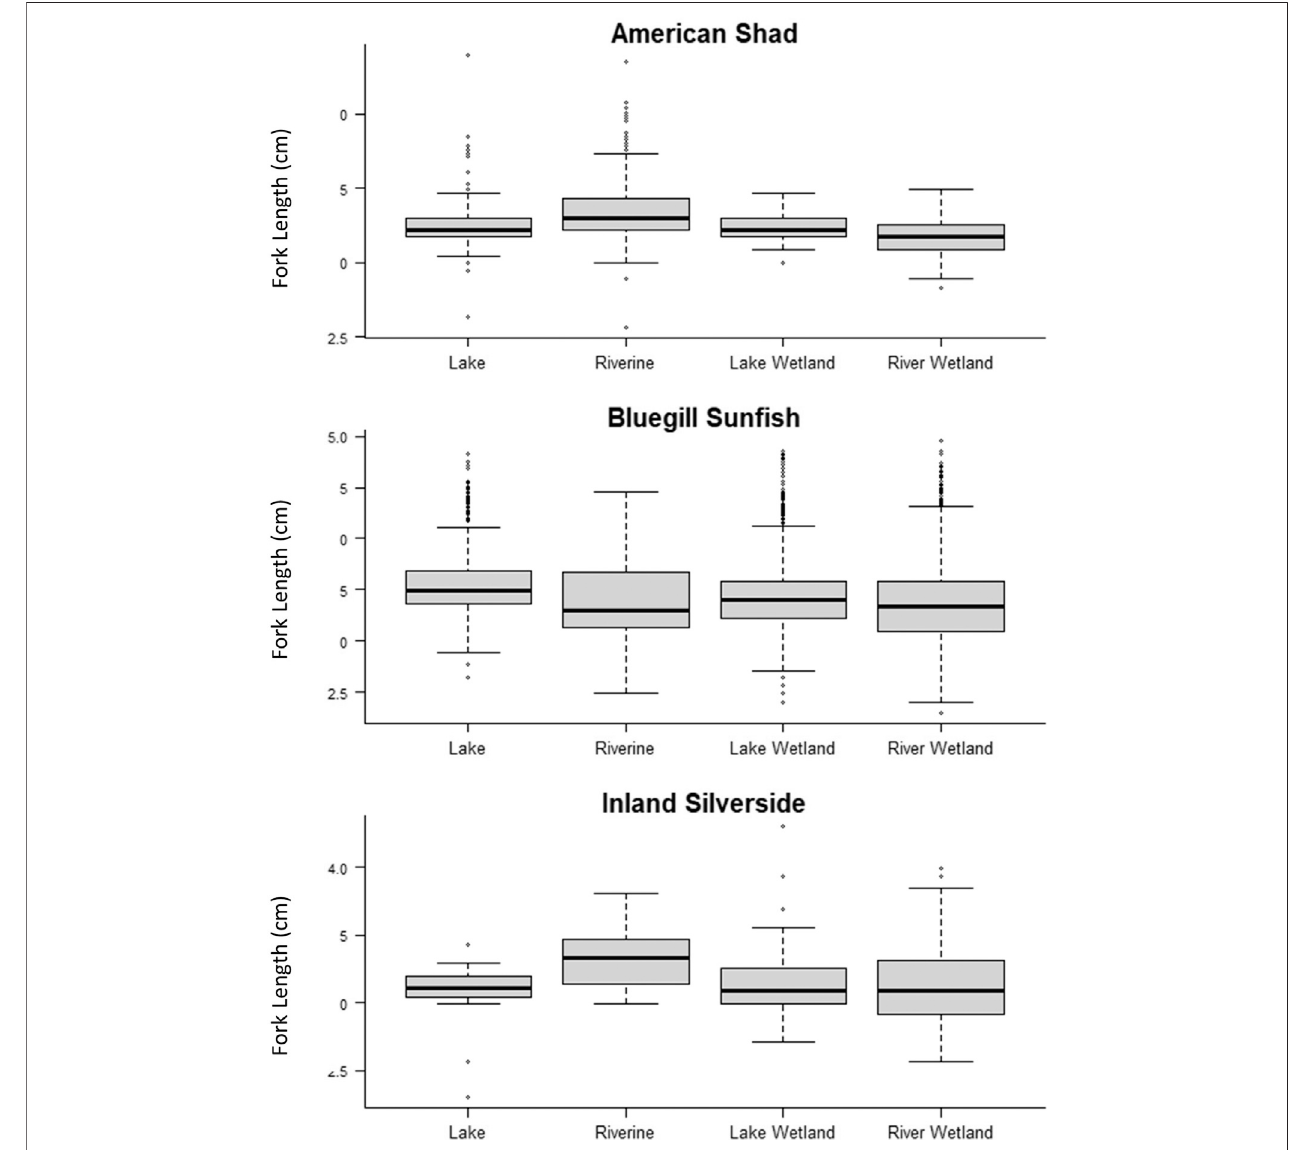
FIGURE 6 | Boxplots of fork lengths of individual fi sh sampled in the different habitat types for the three focal species.